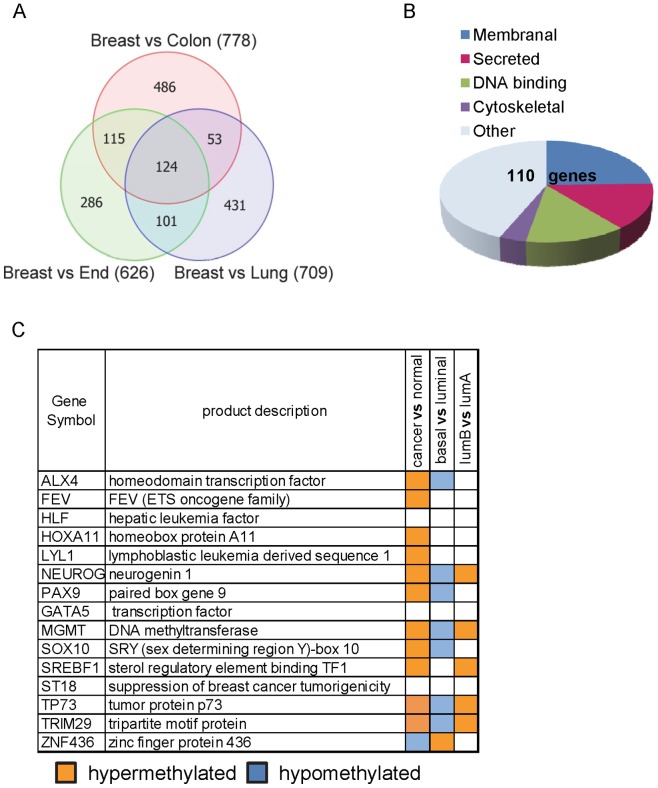
Differentially methylated promoter regions in normal breast epithelium.(A) Venn diagram showing differential methylation loci in breast epithelium (organoids, n = 6) as compared to colon (n = 2), lung (n = 2) and endometrial (End) epithelial tissues (n = 2). About 700 loci (number indicated in brackets) were differentially methylated in breast epithelium when compared to either of the colon, lung or endometrial epithelium. 124 loci had unique methylation patterns in the breast as compared to the other epithelial tissues. Selection of differentially methylated loci was based on a β-value difference >0.2 and a P-value <0.05, after false discovery rate correction, using analysis of variance (ANOVA). (B) Functional classification of 110 genes corresponding to the 124 differentially methylated probes (DAVID Bioinformatics Resources 6.7, NIAID). (C) Selected sub-group of breast specific methylated genes encoding for DNA binding proteins. TCGA analysis (BRCA methylation Illumina 450 dataset, p<0.0001 calculated using Bonferroni corrected t-test) revealed methylation alterations in breast cancers (n = 497) as compared to normal breast tissues (n = 97), in basal (n = 31) versus luminal (n = 144) breast tumors and in luminal-A (n = 99) versus luminal-B (n = 45) tumors. The genomic region analyzed for each gene corresponds with the Illumina probes that were found differentially methylated in breast as specified in Table S3.